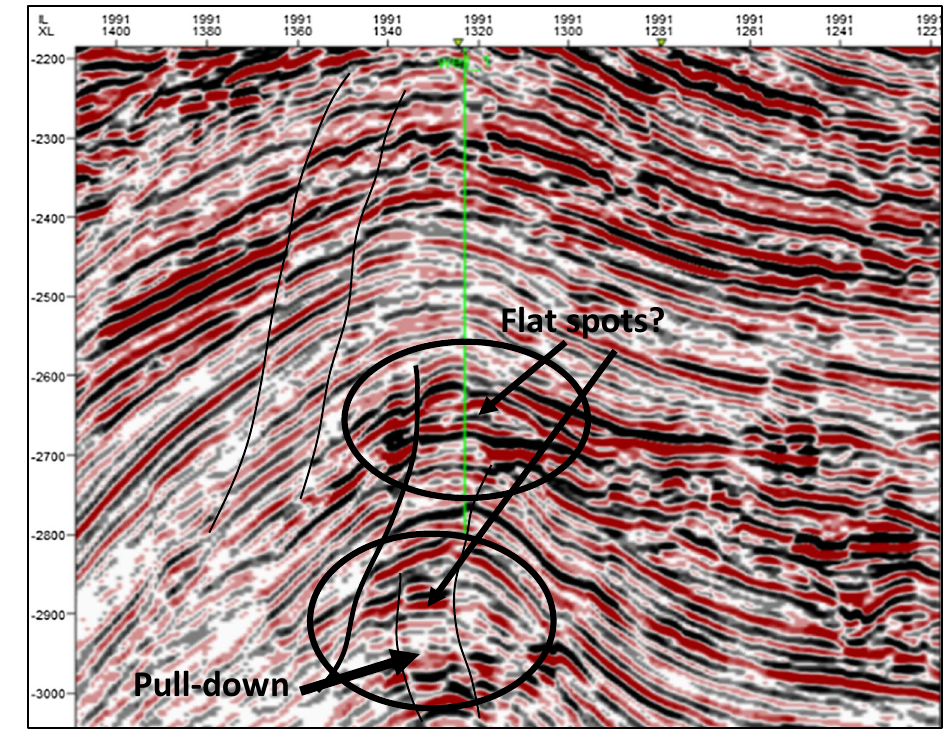
Fig. 3 Well-1 passing through an E–W seismic line, showing anomalies with possible flat spots at two-way time 2695 ms